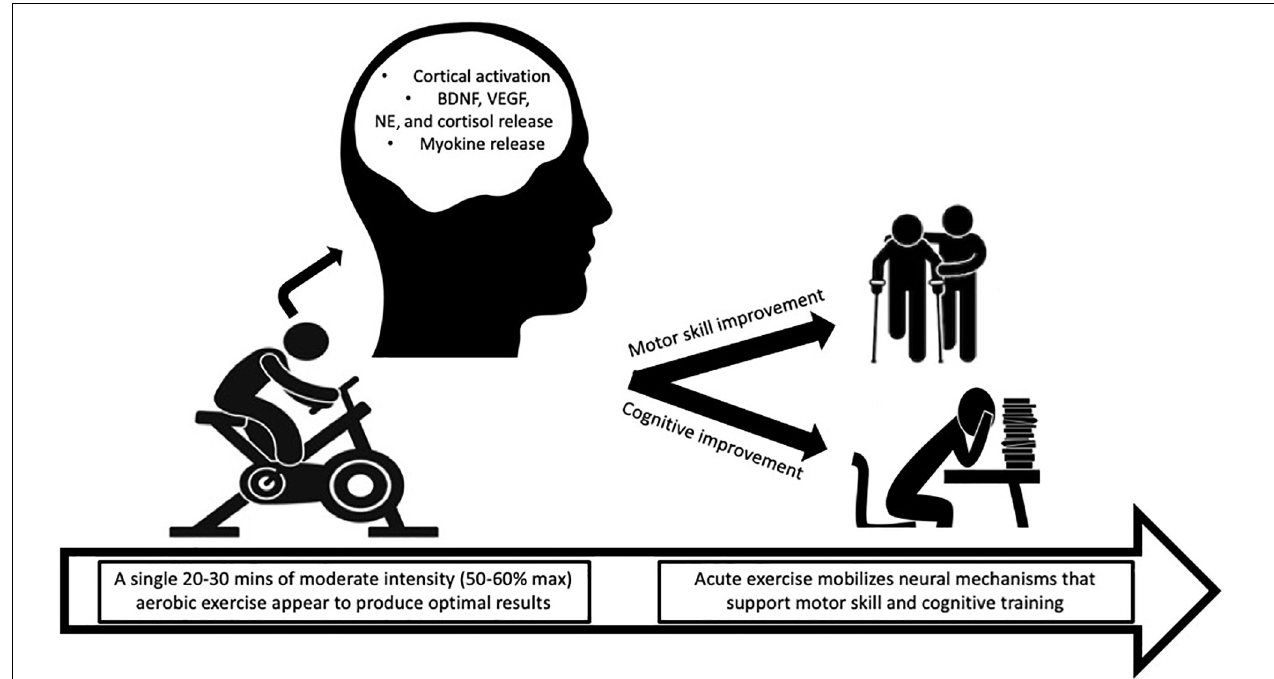
FIGURE 1 | An acute 20–30-min bout of moderate-intensity aerobic exercise may mobilize neural mechanisms that help prime the brain for cognitive and motor performance. BDNF, brain-derived neurotrophic factor; VEGF, vascular endothelial growth factor; NE,